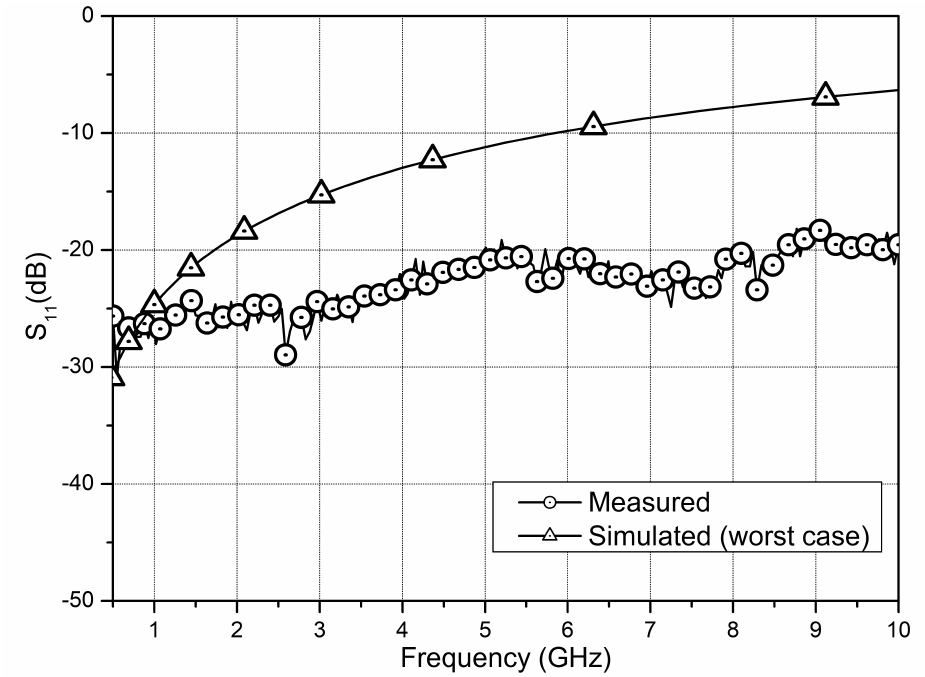
Figure 12. Measurement and simulation of the input return loss S 11 for for I 01 = 600 µ A and I 02 = 50 µ A.